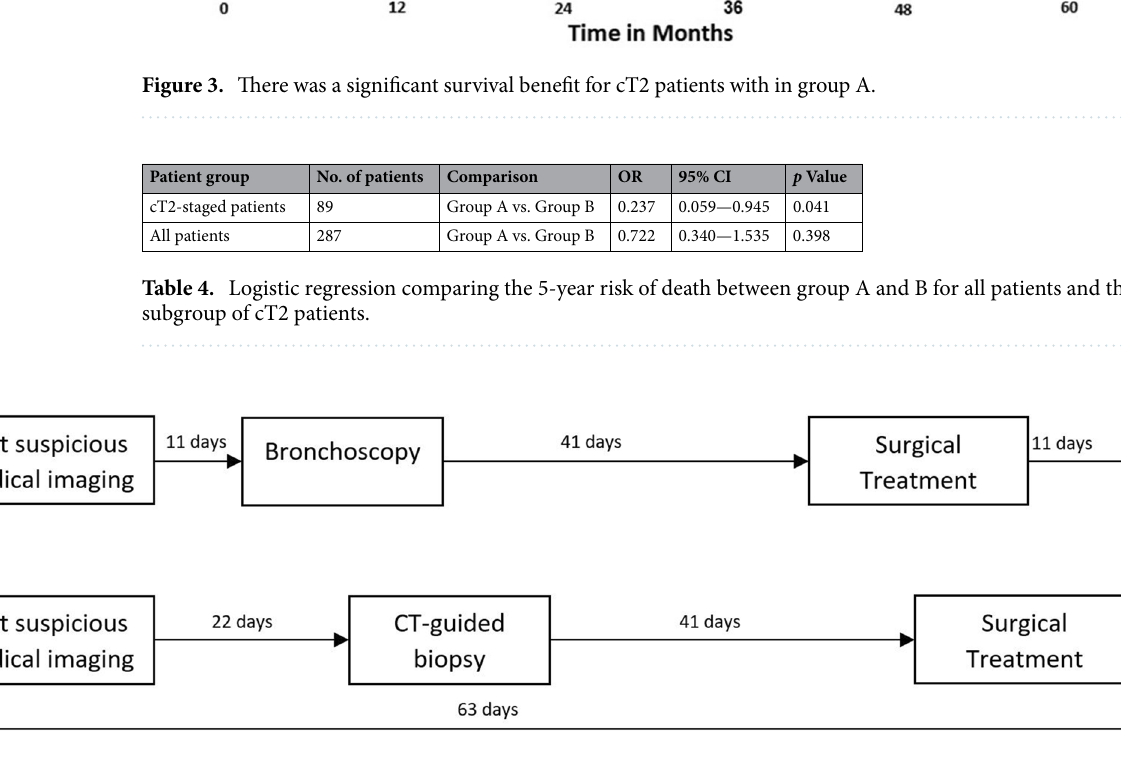
Figure 4. Timeline for delay between first suspicious medical imaging and surgical treatment in stage cT2 patients. CT-guided tissue confirmation adds 11 days of additional delay to the process compared to bronchoscopy alone ( p =